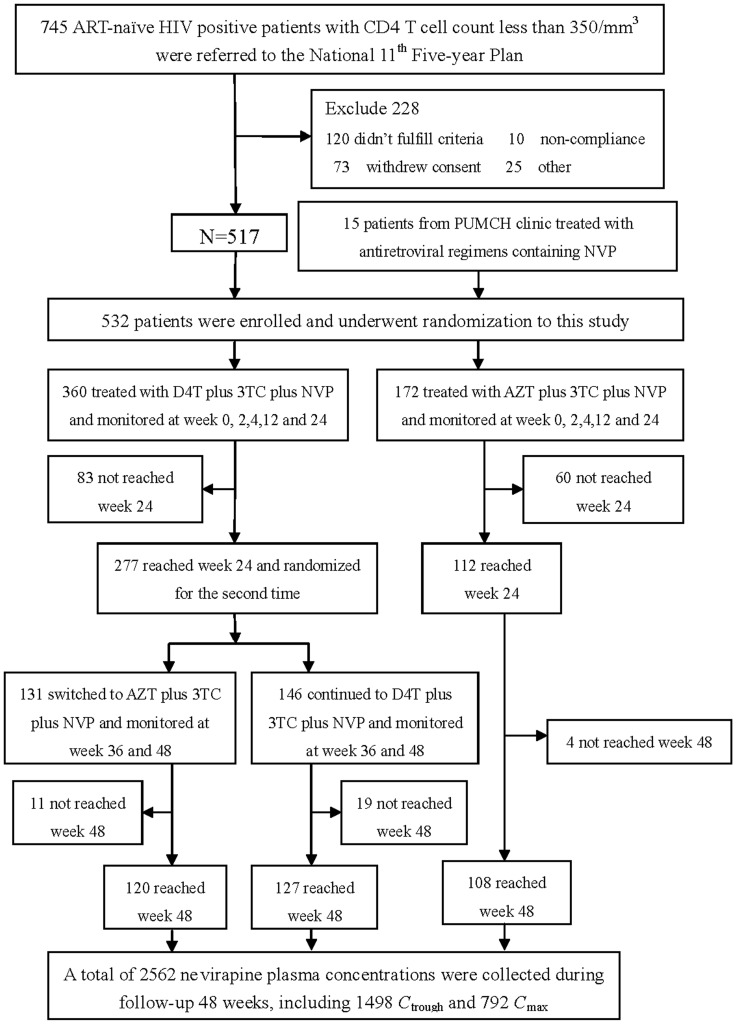
Flow chart of participants through the clinical trial.ART: antiretroviral therapy; AZT: zidovudine; NVP: nevirapine; 3TC: lamivudine; D4T: stavudine; Ctrough: trough concentrations of nevirapine; Cmax: peak concentrations of nevirapine.